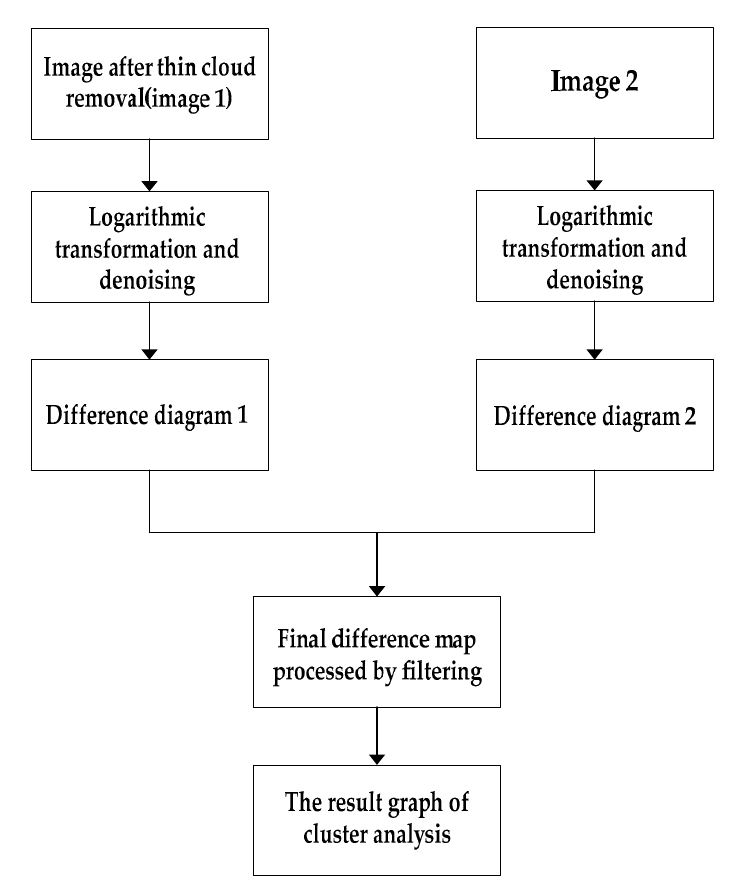
Figure 5. Change detection algorithm.